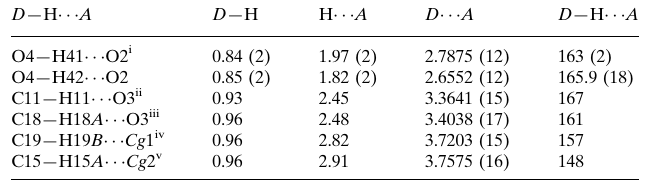
Hydrogen-bond geometry (A˚ , (cid:2)